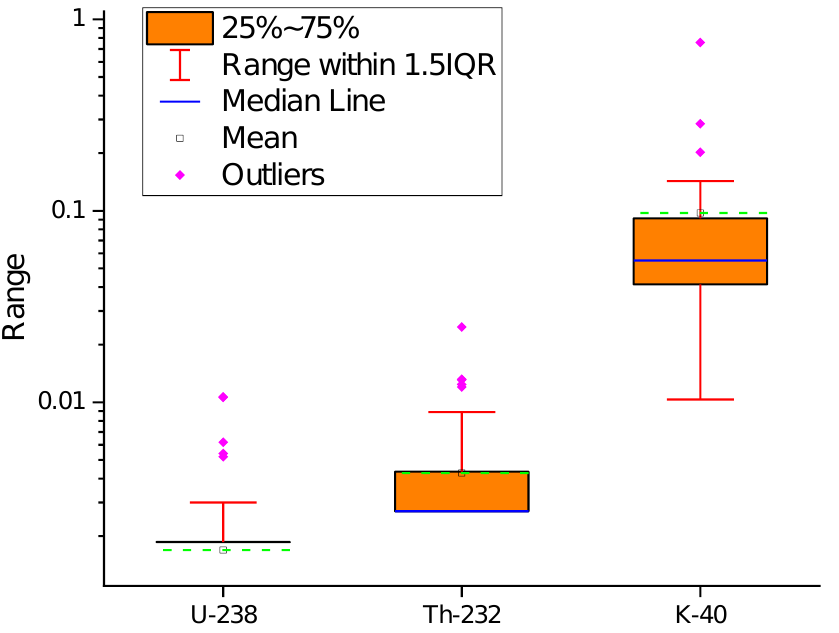
Figure 4. Range, mean, median line, and outlier radioactive elements ( 238 U, 226 Ra, 232 Th, and 40 K radionuclides) for measured samples in the interested area.